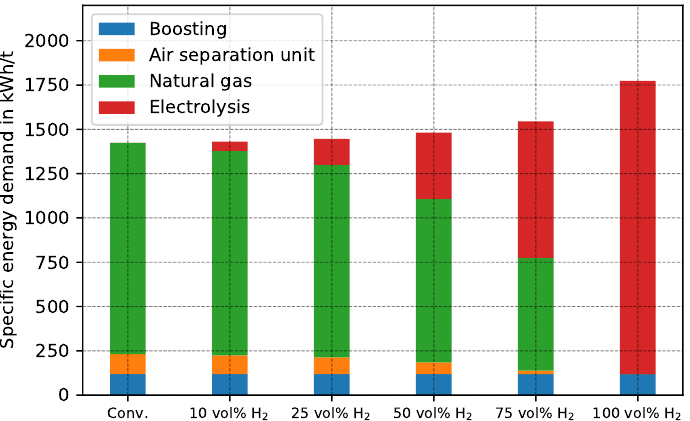
Figure 11. Comparison of the proportional specific energy demand per ton of molten glass caused by boosting, air separation unit (ASU), natural gas and electrolysis between the integration of PtH 2 in oxyfuel-based glass melting processes with various H 2 vol% in the fuel mixture and the conventional scenario (i.e., 0 vol% H 2 in the fuel